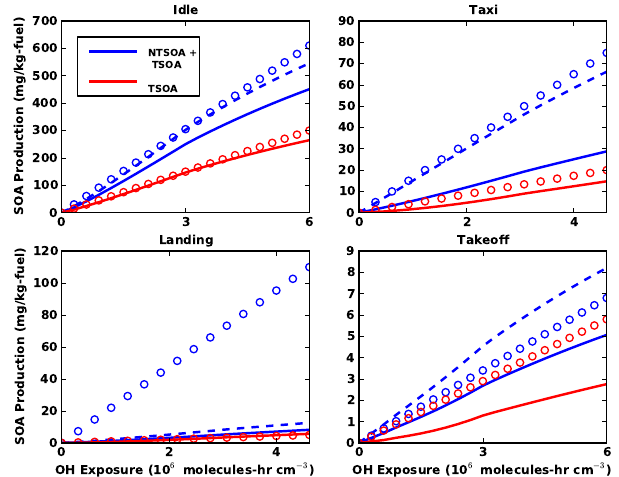
Figure 1. Comparison of traditional (TSOA) and non-traditional SOA (NTSOA) predictions in CMAQ (solid lines), box model re- sults reported by Jathar et al. (2012) (circles) based on measure- ments from Miracolo et al. (2011), and NTSOA predictions in CMAQ with 1.5 times increased yields (dashed lines) for a CFM56- 2B engine at idle (4% power), taxi (7%), landing (30%), and take- off (85%). OH exposure is the integration of OH concentrations over time to account for differences in OH concentrations between the two models.